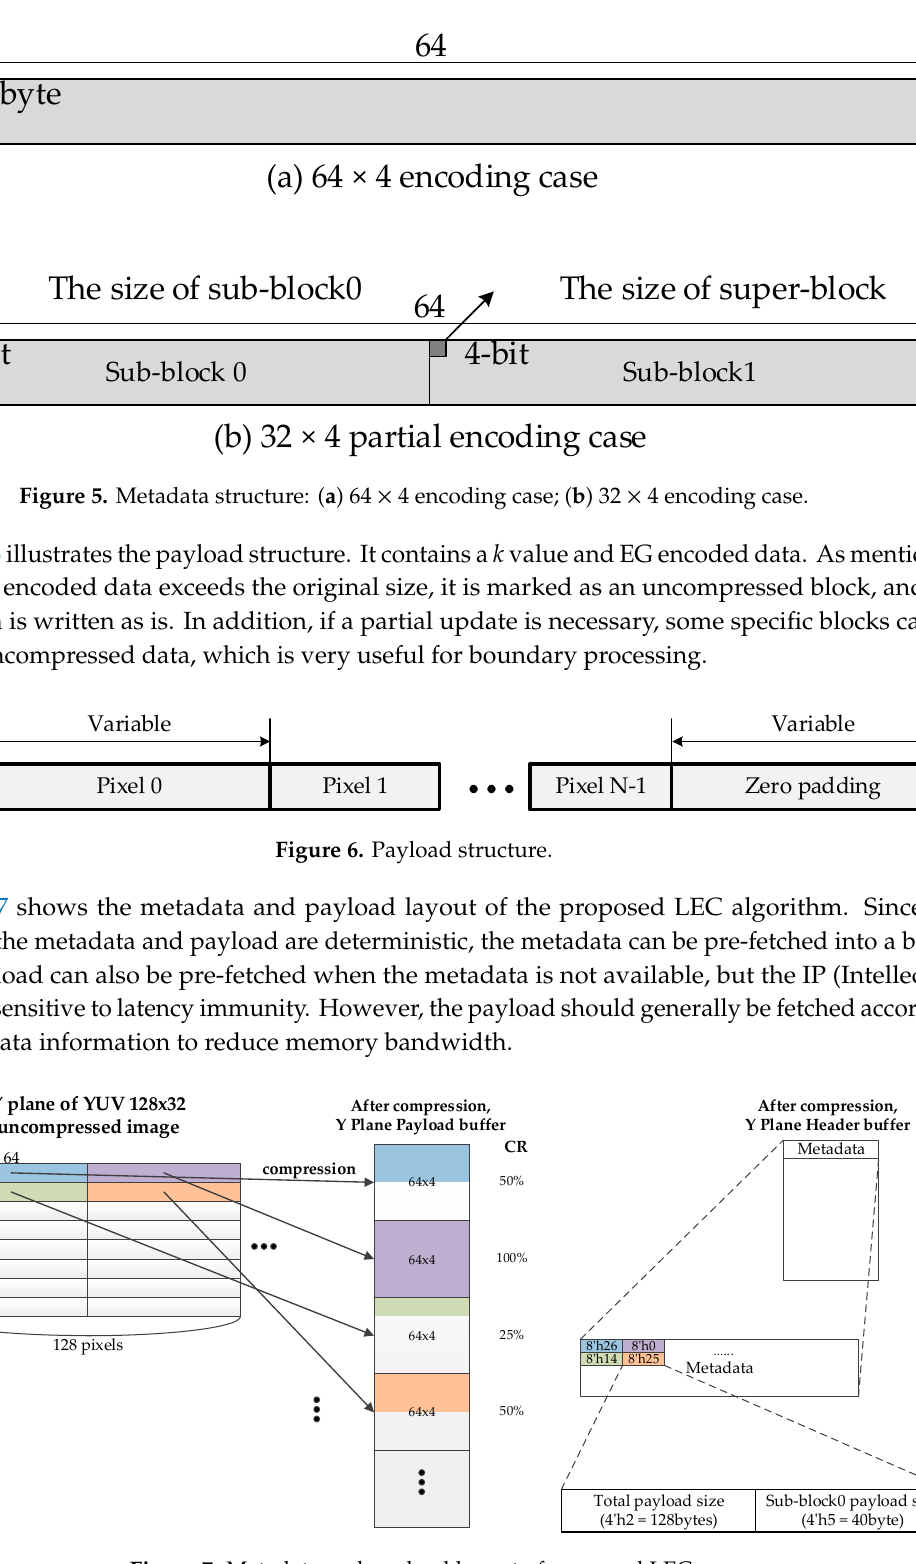
Figure 7. Metadata and payload layout of proposed LEC.